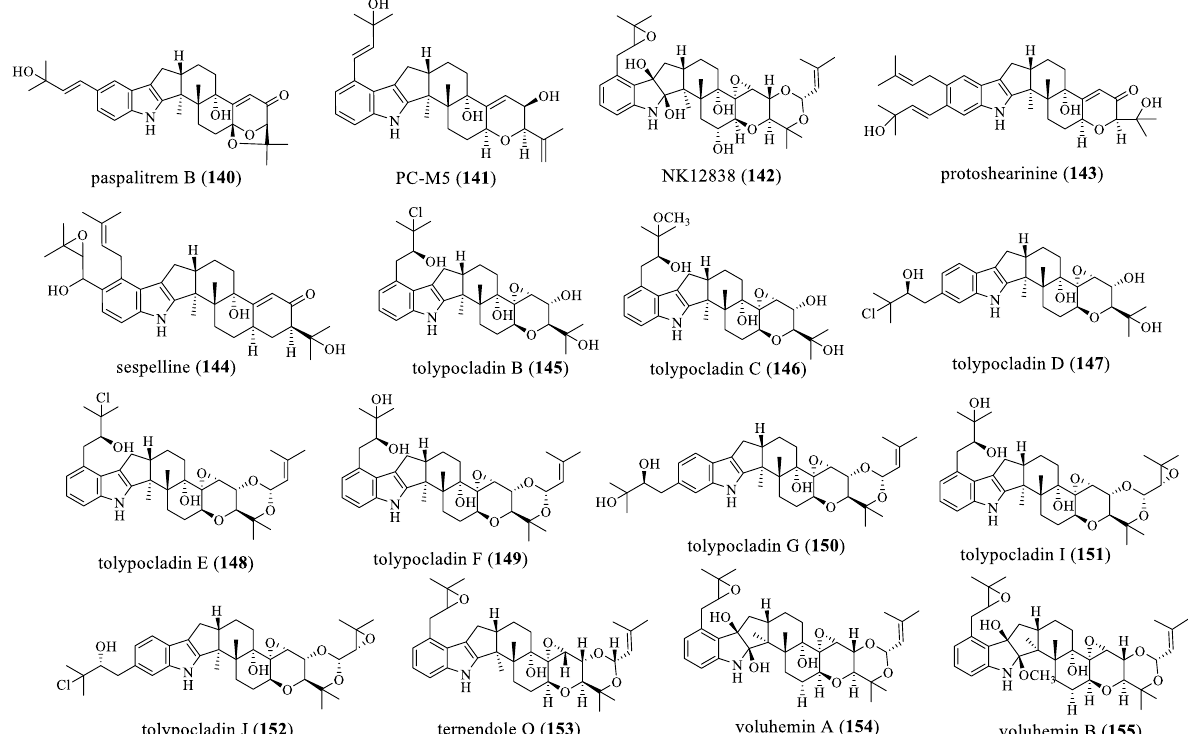
Fig. 10 Chemical structures of paspaline‑type compounds in which the isopentenyl group on the A‑ring is